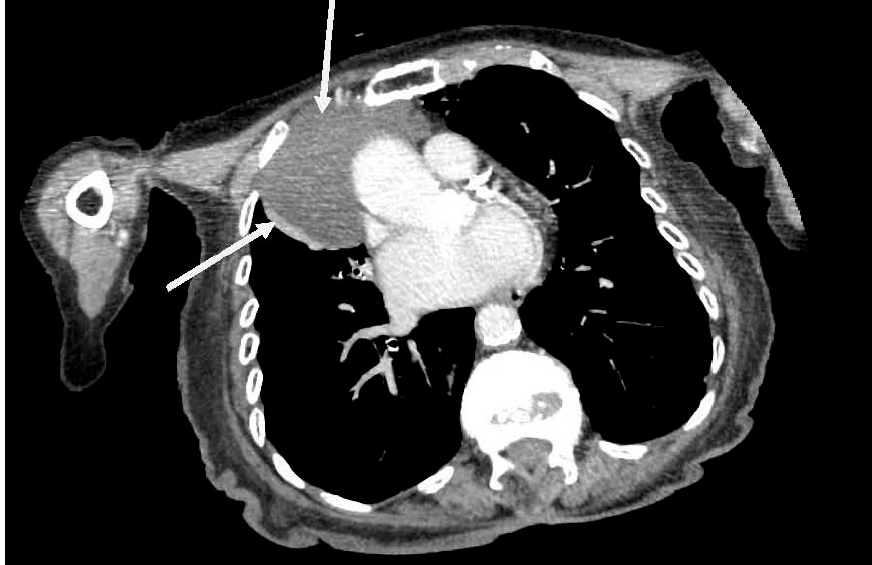
Figure 2. Axial computerised tomography (CT) showing an 8 cm × 5 cm low attenuation right sided soft tissue mass arising from pericardium and abutting the anterior mediastinum and anterior chest wall (arrows).